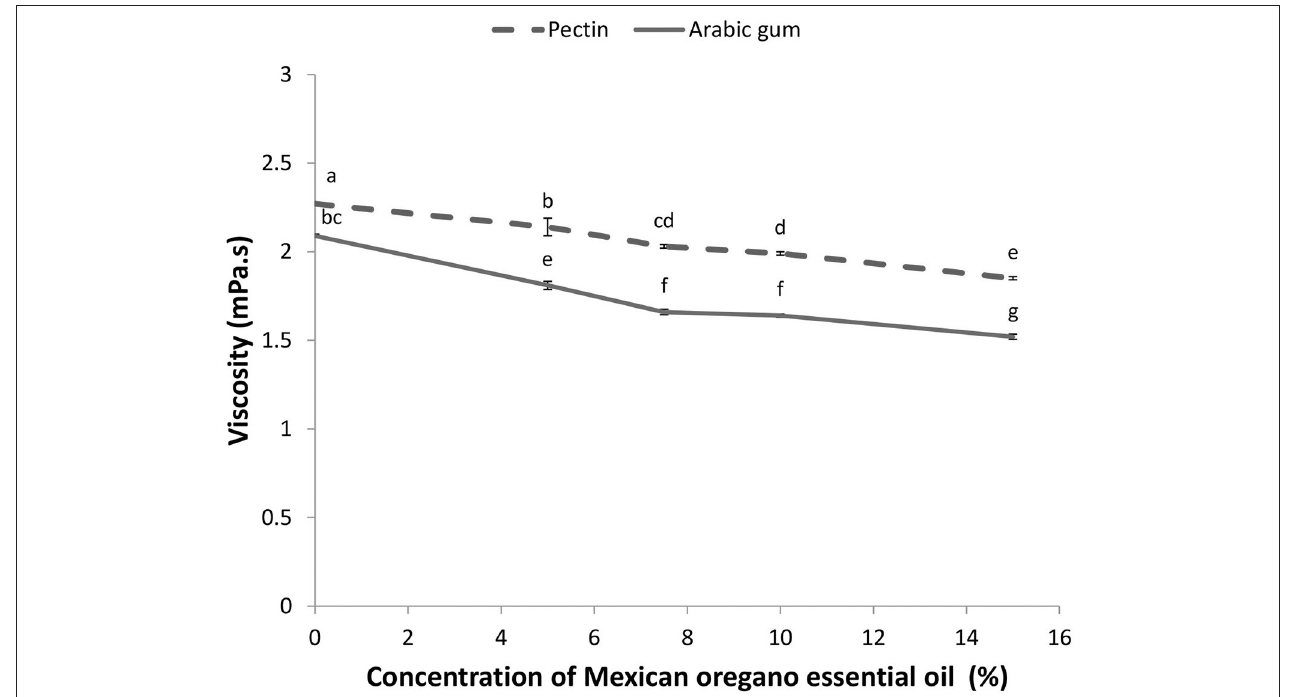
FIGURE 1 | Viscosity of the different emulsion systems using pectin or Arabic gum determined at time 0. Arithmetic means that do not share the same letter are significantly different ( p < 0.05).